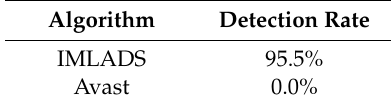
Table 5. The comparison between IMLADS and